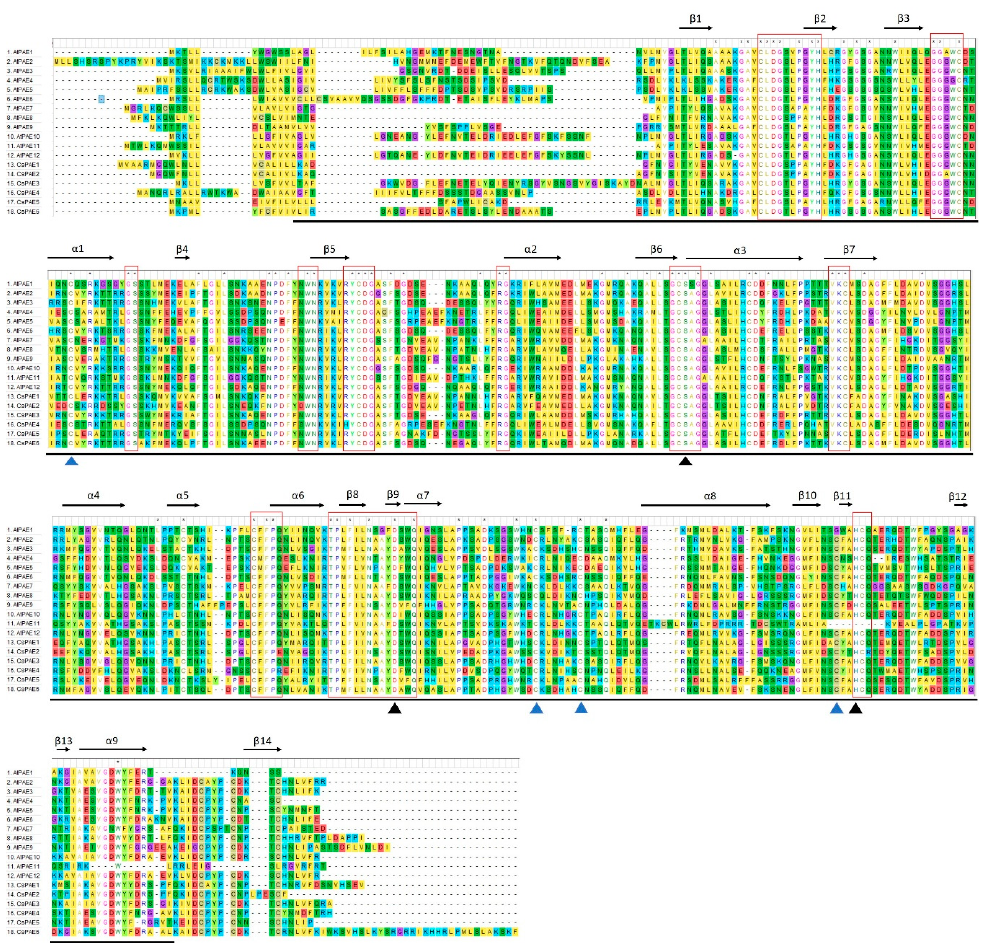
Figure 2. Alignment of the protein sequences of CsPAEs and AtPAEs. The Muscle tool in MEGA V7.0 was used for the alignment of full-length A. thaliana and C. sinensis PAEs. Red rectangles were used to highlight conserved PAE motifs. Secondary structural elements are shown by black arrows along the top of the protein sequences, with α and β corresponding to α -helices and β -strands, respectively. The S, D, and H active catalytic sites are marked using black triangles, while cysteine residues capable of disulfide bond formation are marked by blue triangles. Consensus sequences are marked an asterisks over the corresponding residues.